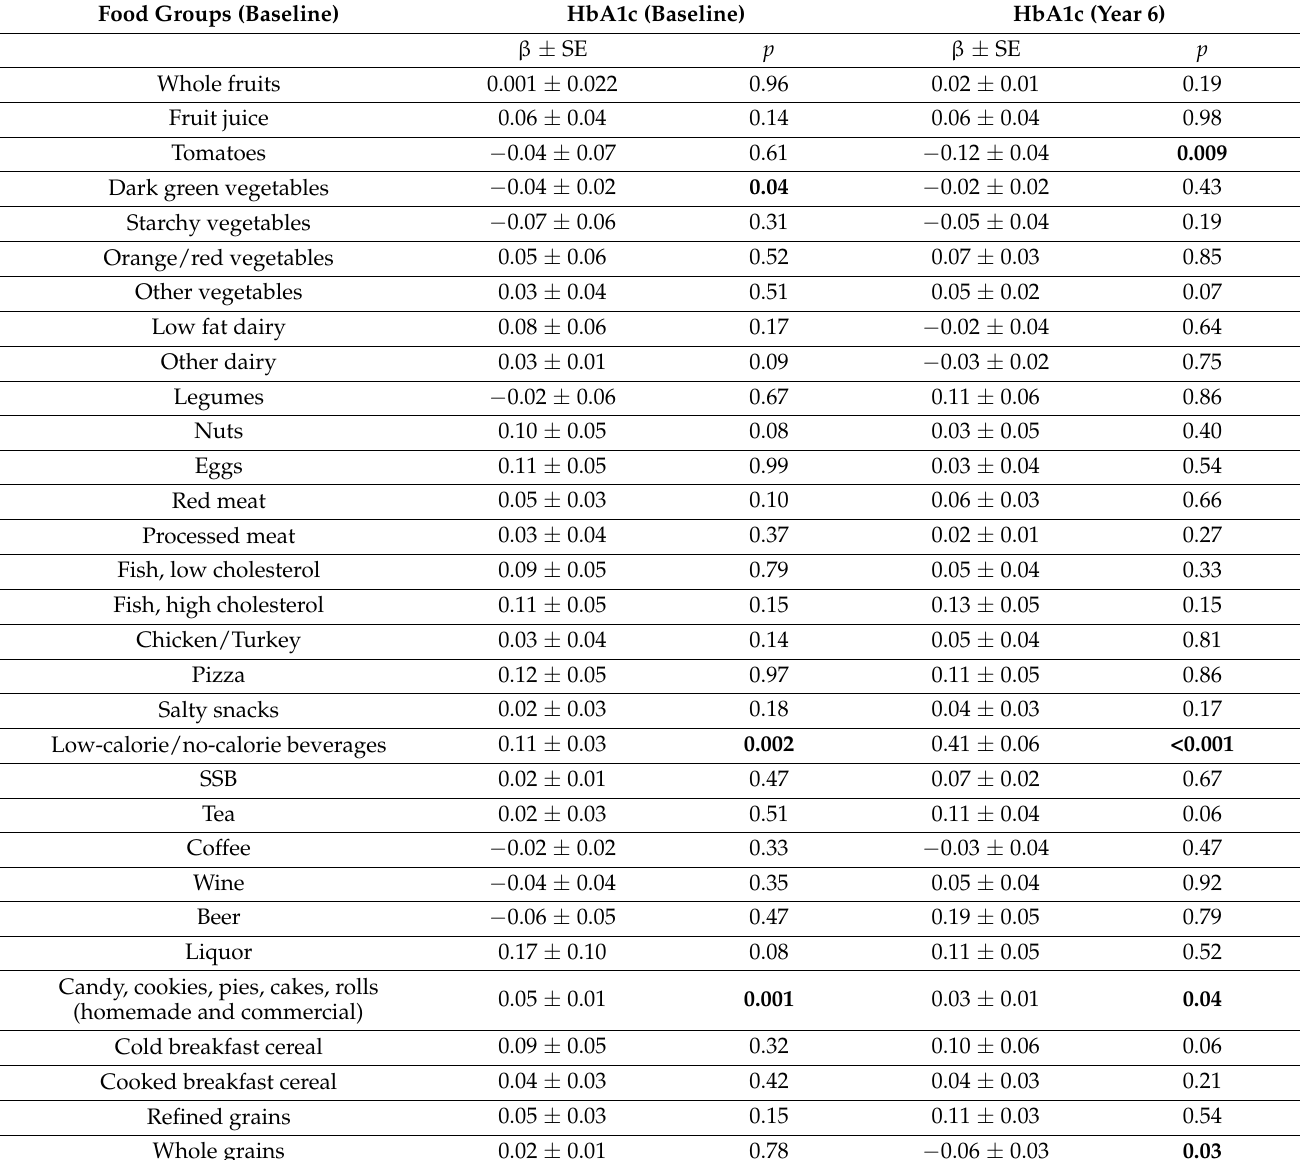
Table 3. Associations of food groups with HbA1c in adults with and without